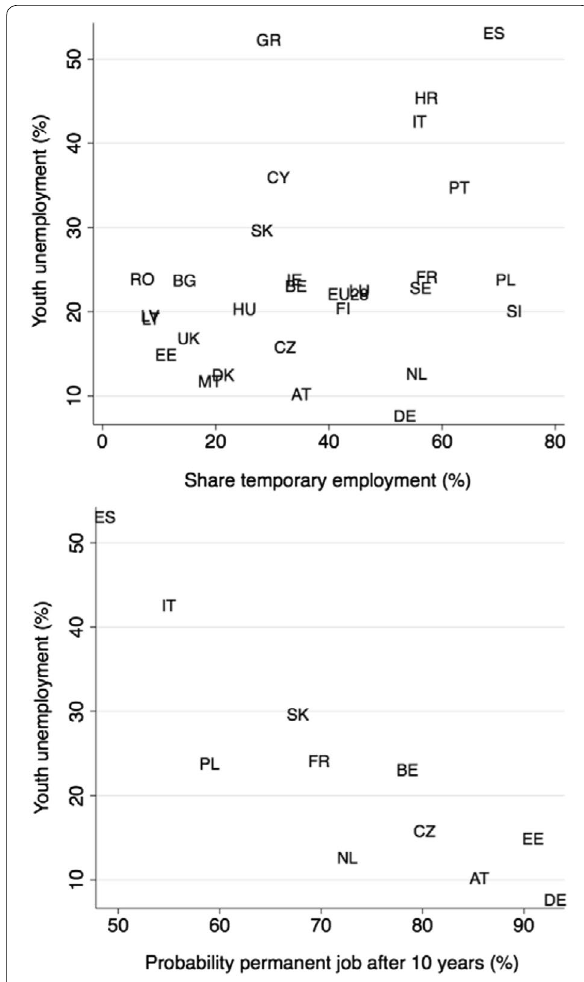
Fig. 4 Youth unemployment, temporary employment and transition probabilities ( Source Youth unemployment and share temporary employment: Eurostat (2015); Probability permanent job after 10 years: OECD (2015, pp.